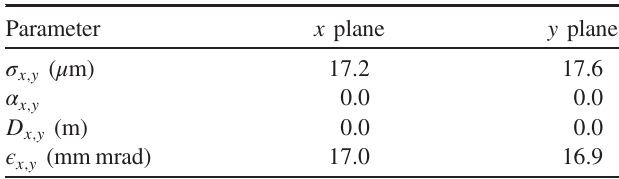
TABLE VI. Beam parameters at the injection point for a transfer line with two 100 μ m aluminum